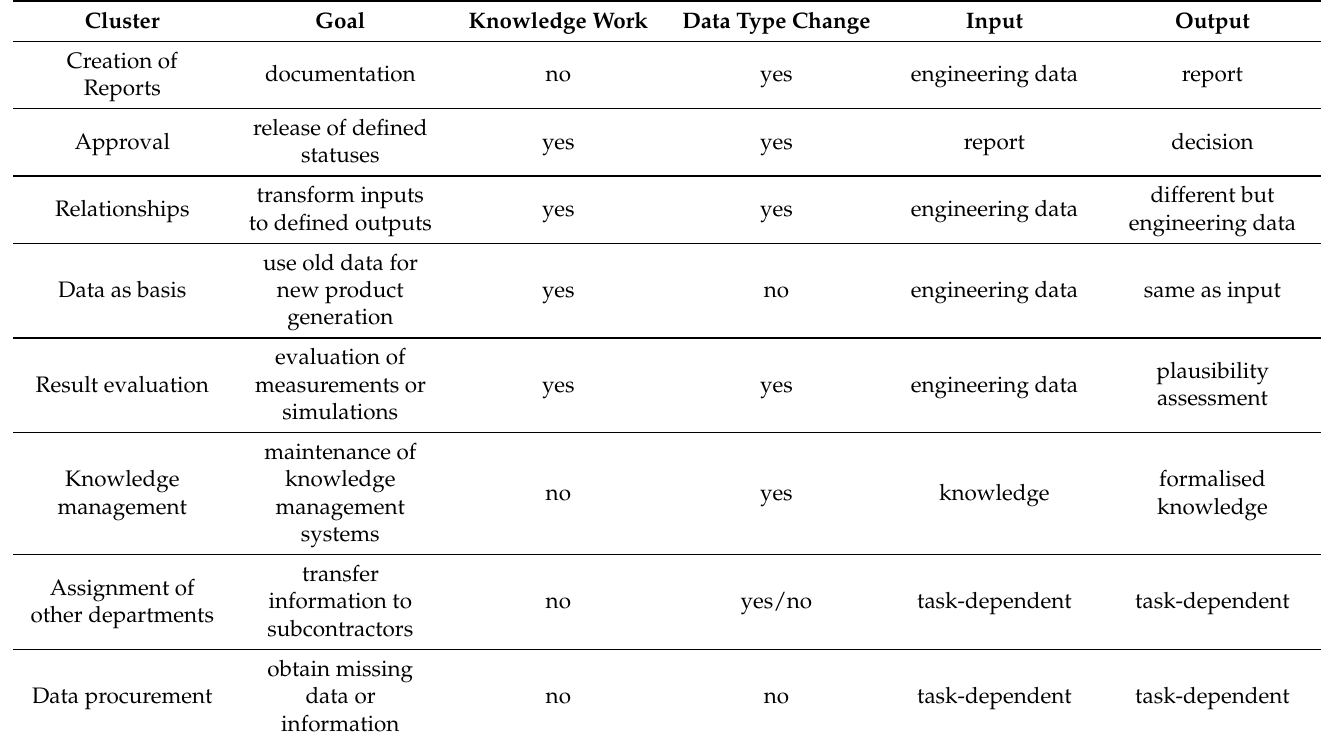
Table 1. Overview of the defined task